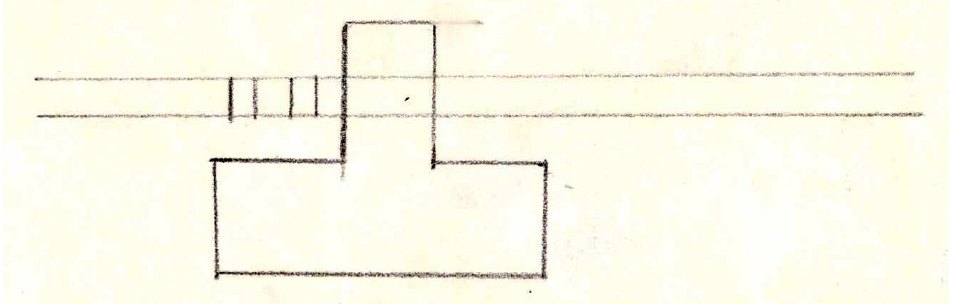
Figure 2. Von Neumann introduced what he called Turing’s ‘logic machine’ at the start of Lecture 3, using this diagram (Figure 1 of the lecture) depicting the tape and the scanner with its control mechanism. Courtesy of the American Philosophical Society.